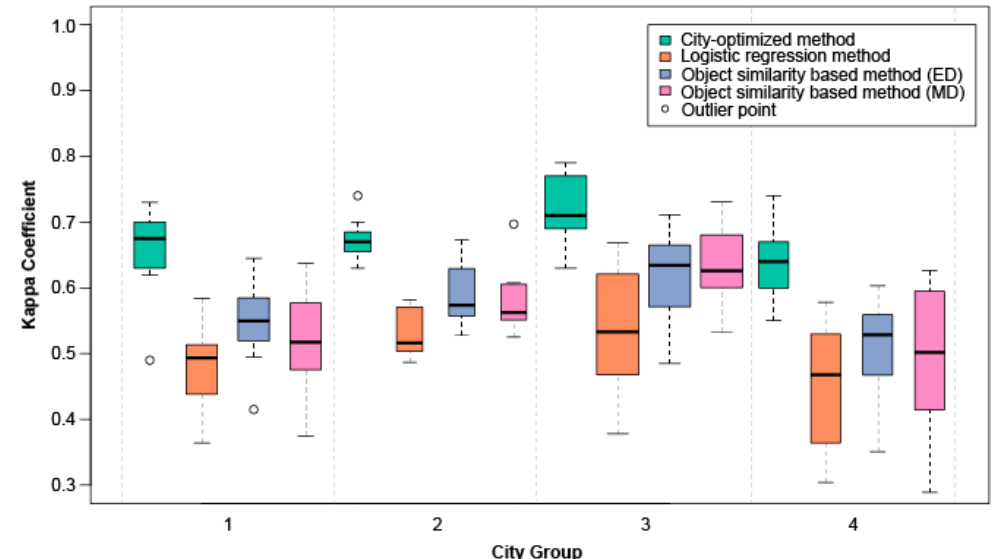
Figure 8. Boxplot of the Kappa Coefficients for each city group for each method, based on the minimum, first quartile, median (the bold line), third quartile, and maximum. Note: 1. The Kappa Coefficient for a city of the object similarity-based method and the logistic regression method refers to the average result of different tests; 2. the widths of the boxes are proportional to the square roots of the number of observations in the